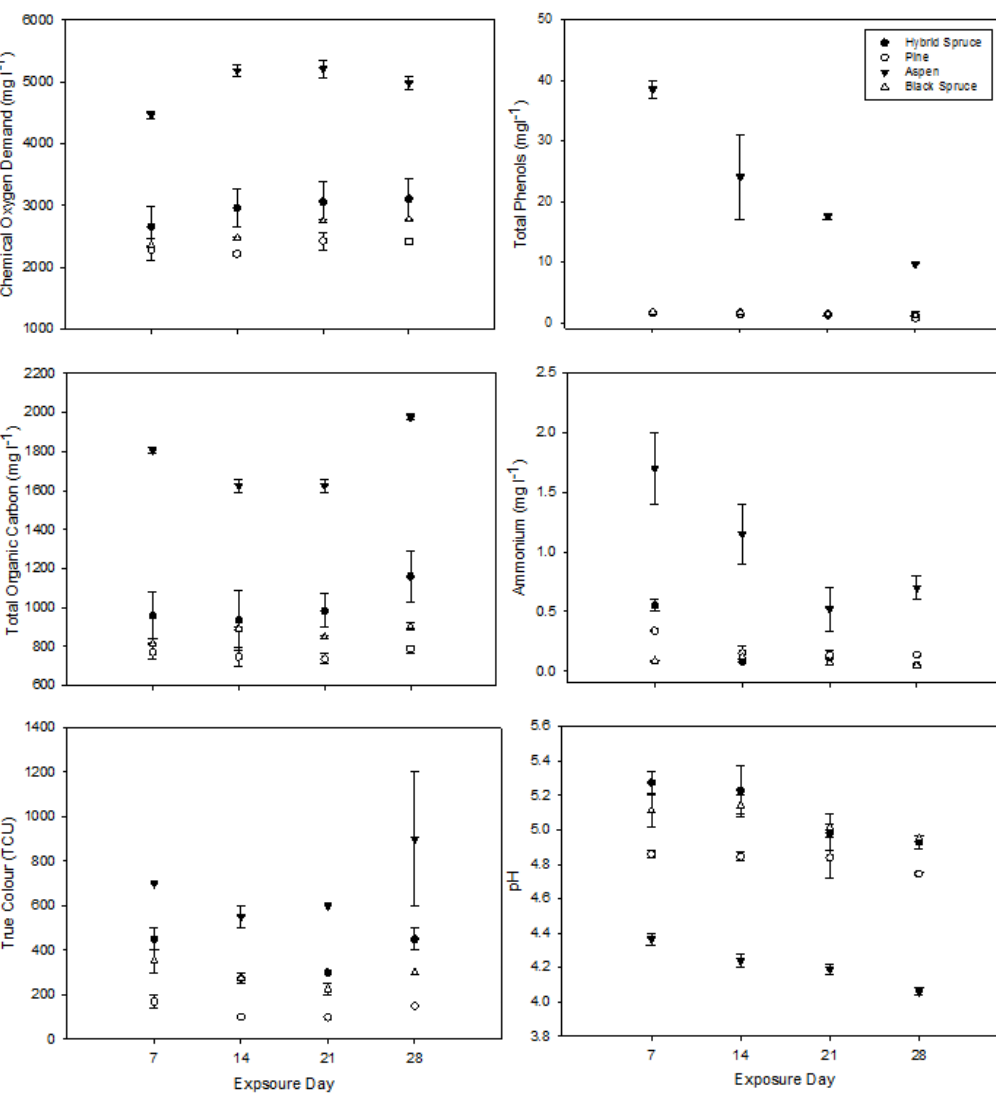
Figure 4. Static leachate chemical conditions over the 28 ‐ day sample period. Bars represent standard error ( n = 2). Table 2. Kruskal ‐ Wallis summary statistics to identify differences between tree species across the 4 ‐ week sample period ( df = 3).